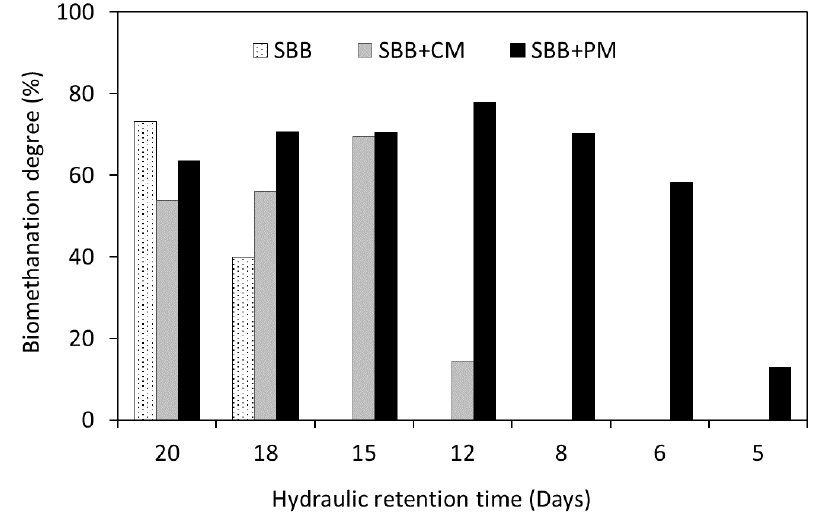
Figure 2. Biomethanation degree in the three SSTR digesters.